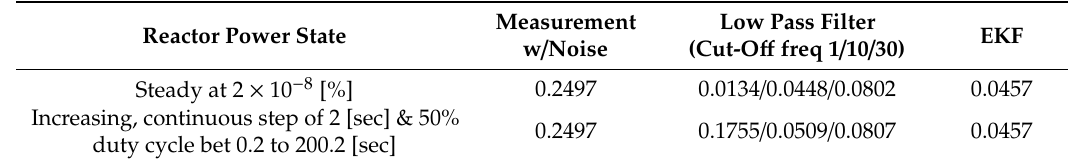
Table 4. Reactor power estimation